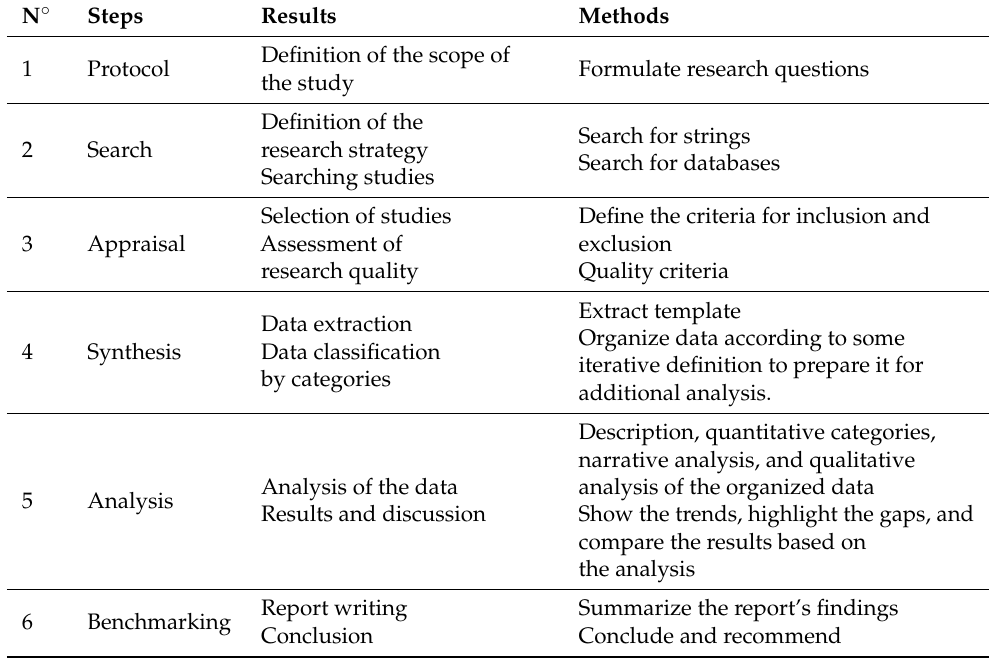
Table 2. Steps of SLR and meta-analysis